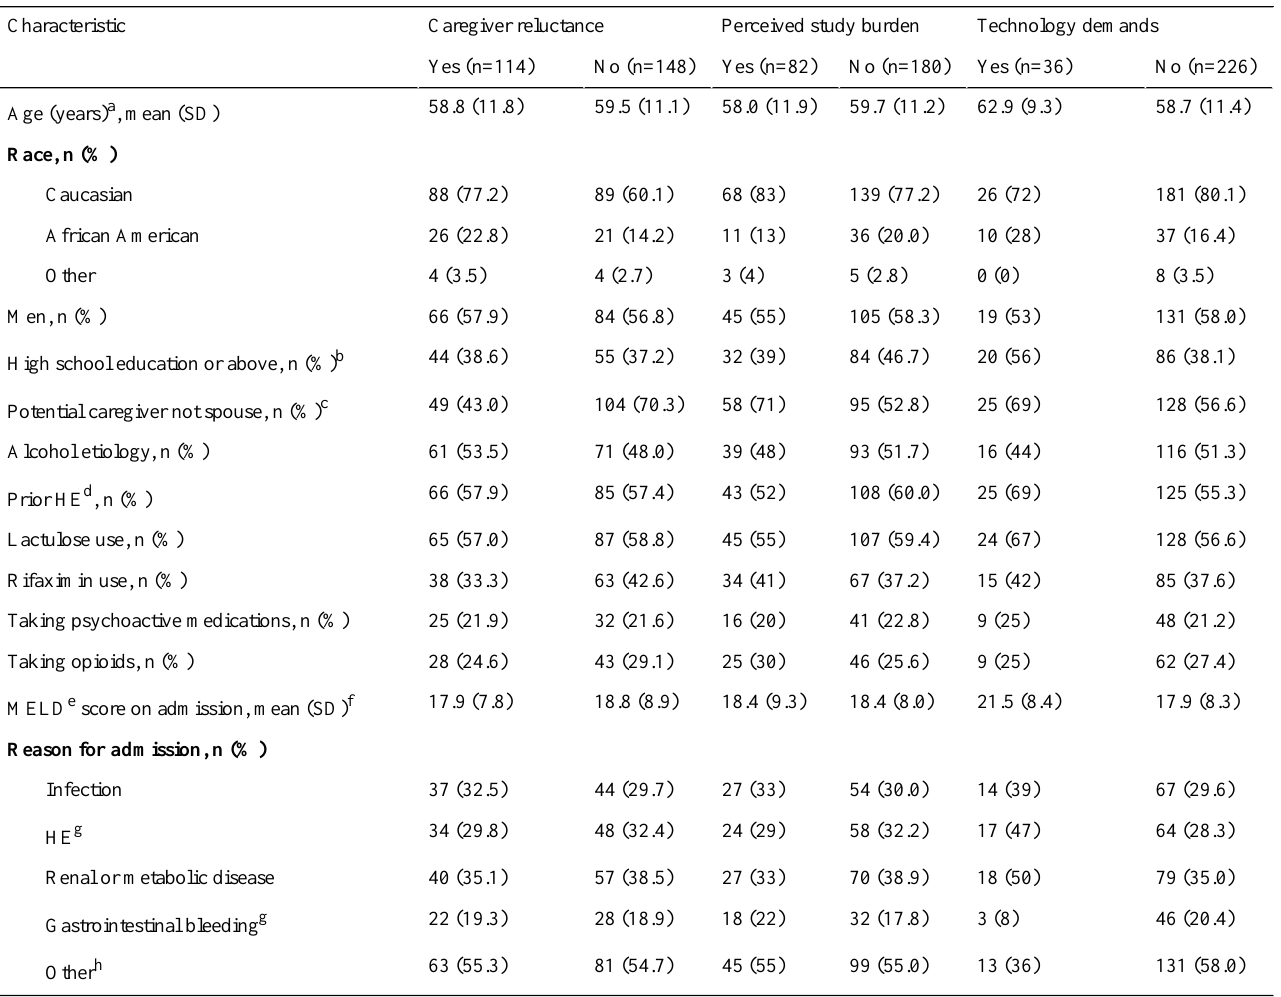
Table 2. Reasons for refusal to participate in relation to patient characteristics (N=262).